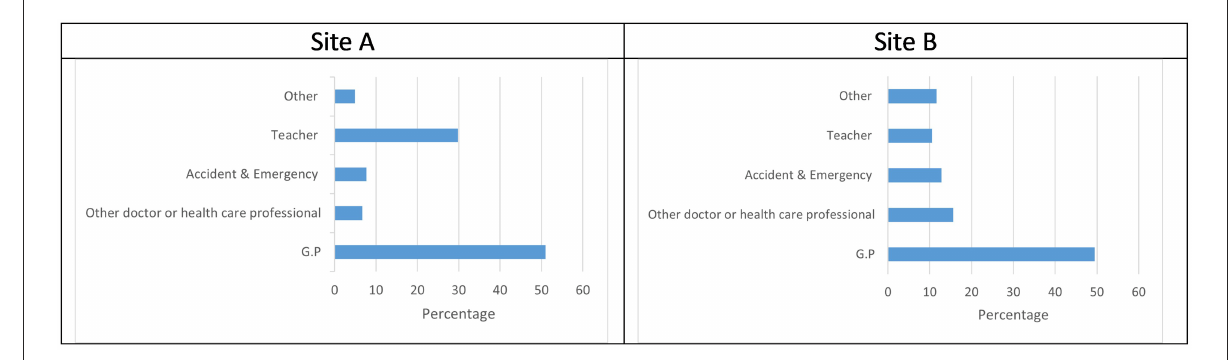
FIGURE4 (A,B) Occupation of referrer.